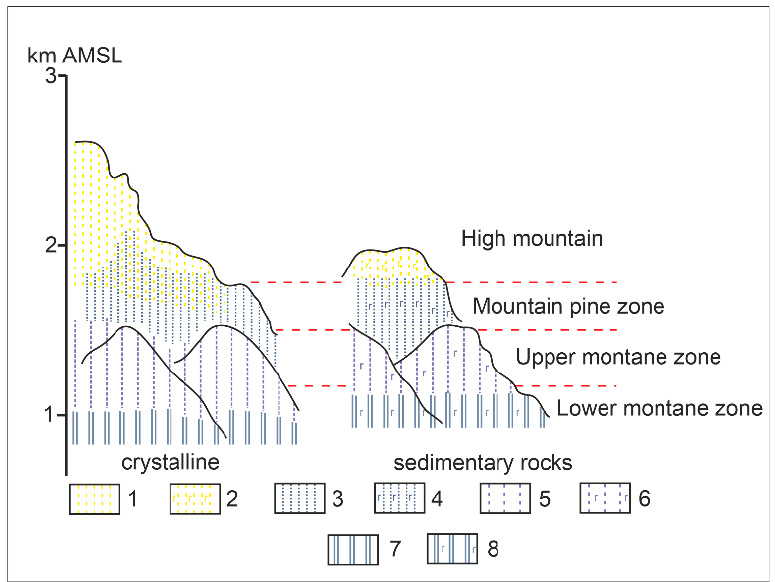
Figure 2. Differentiation of soils in the crystalline and sedimentary rocks of the Tatra Mountains [33,34] . 1—Lithic/Nudilithic Leptosols; 2—Calcaric Lithic/Nudilithic and Hyperskeletic Leptosols; 3—Albic/Protospodic and Dystric Folic Leptosols; 4—Dystric Folic Leptosols; 5—Albic Podzols; 6—Dystric Folic Leptosols; 7—Albic Podzols, Dystric Cambisols (Protospodic); 8—Rendzic Phaeozems, Dolomitic/Calcaric Leptic Cambisols.